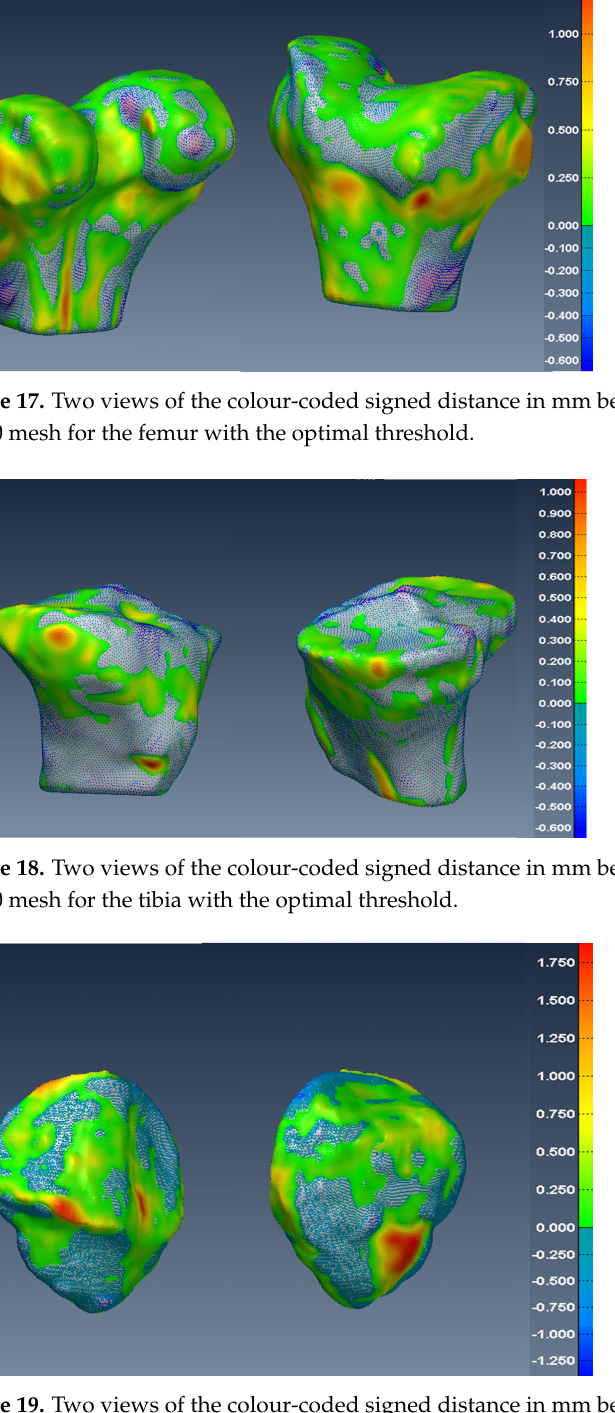
Figure 19. Two views of the colour-coded signed distance in mm between the U-Net mesh and the UofA mesh for the patella with the optimal